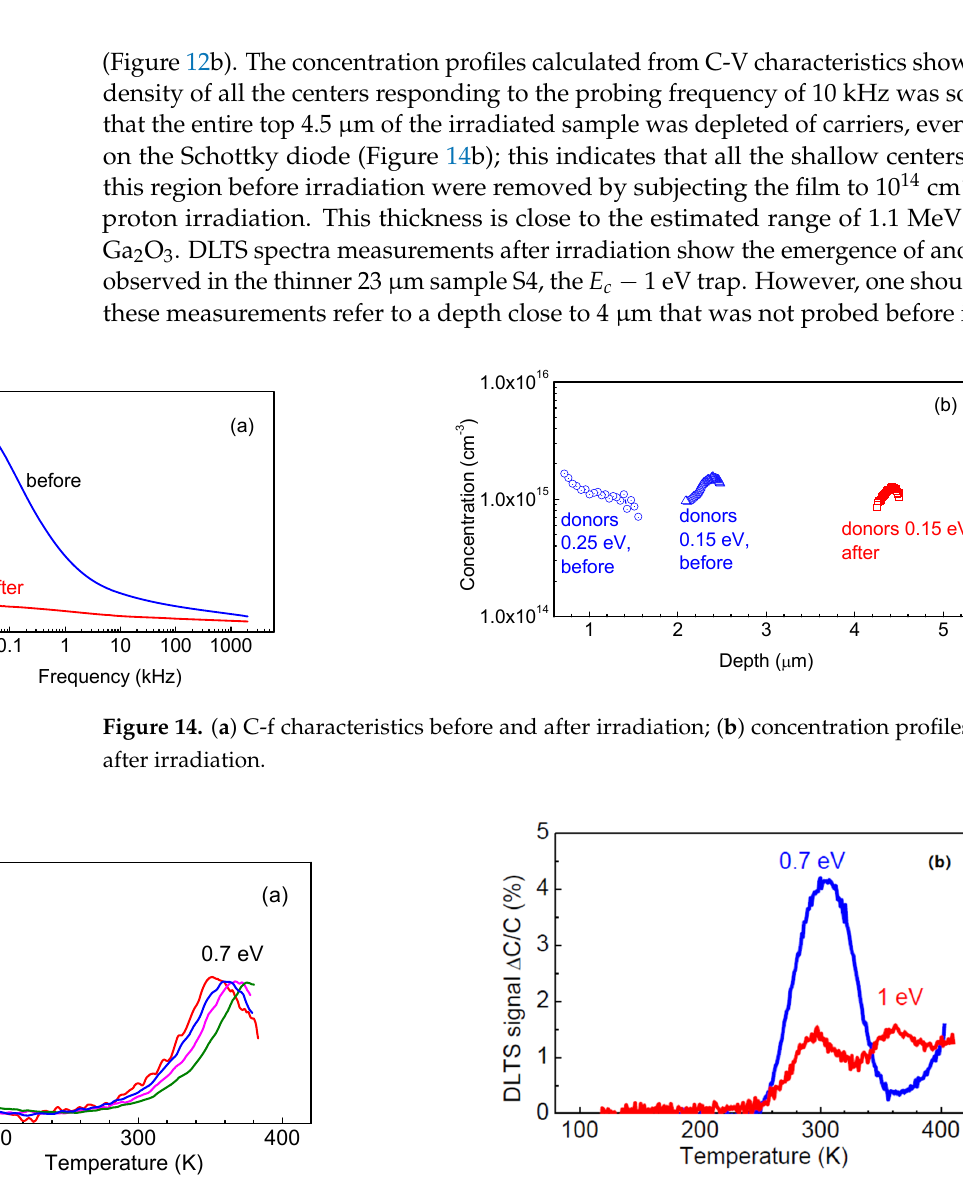
Figure 13. Photocurrent at − 1 V normalized by dark current for measurements before and after ir ‐ radiation.